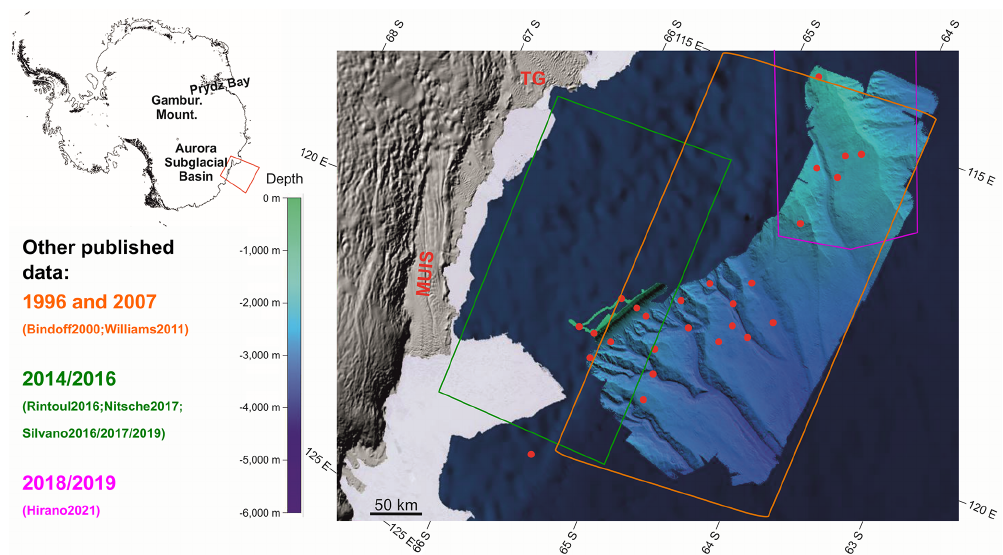
Figure 1. Sabrina Seafloor Survey area. Red dots indicate CTD casts collected during the IN2017_V01 cruise. Coloured polygons, instead, indicate areas where other already published hydrological data have been taken (reference years and related articles are indicated on the left). The high-resolution bathymetry is obtained from multibeam data acquired during the IN2017_V01 cruise (from O’Brien et al., 2020). On land, the terrain map comes from the Reference Elevation Model of Antarctica (REMA, Howat et al., 2019). The colourbar on the left refers to the high-resolution multibeam